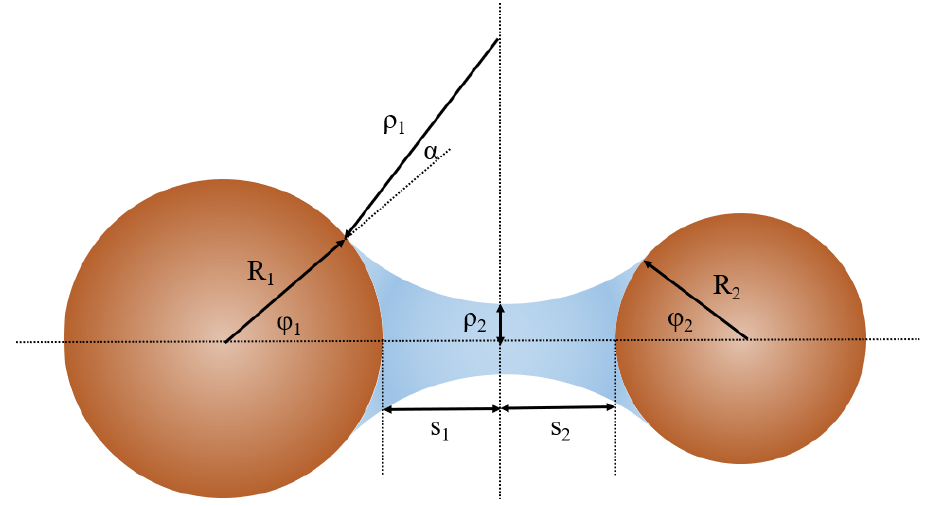
Figure 2. Toroidal model of the liquid bridge between two unequally sized